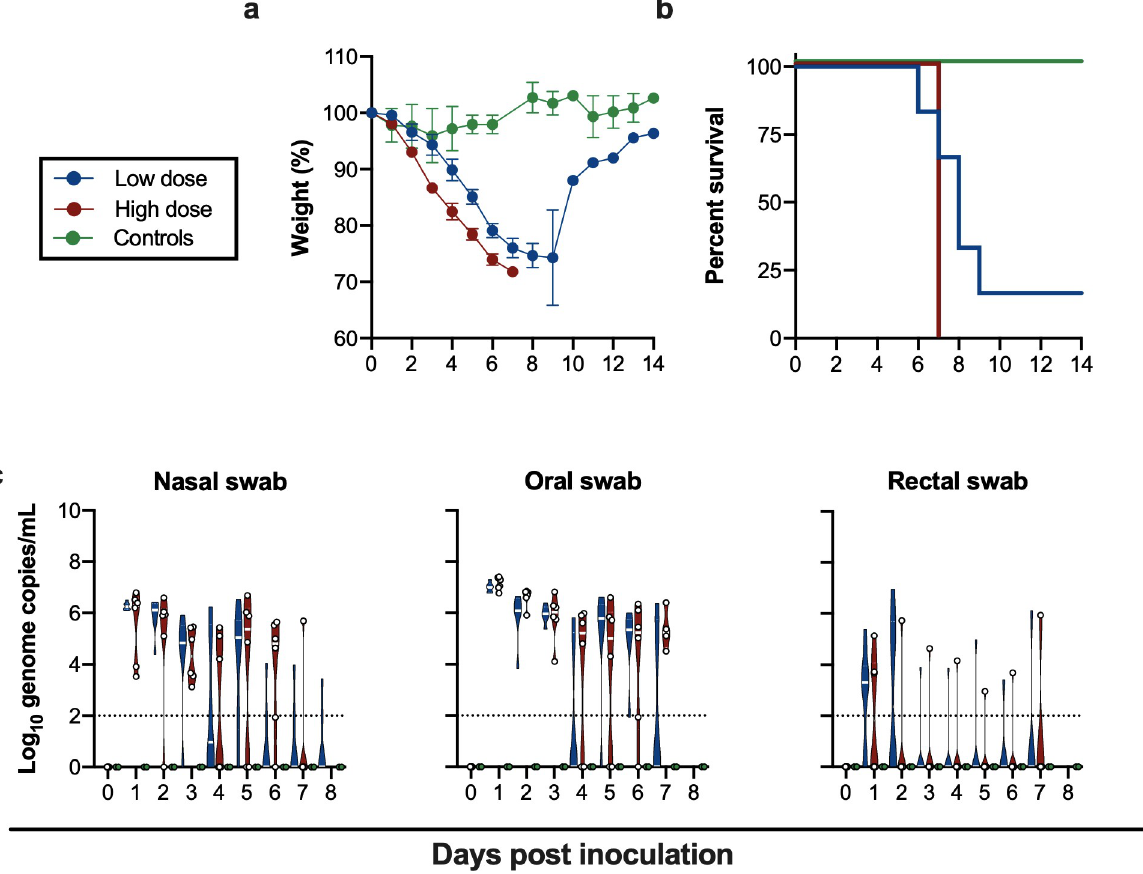
Fig 1. Inoculation of K18-hACE2 mice results in lethal infection and virus shedding. . a . Relative weight loss in mice after SARS-CoV-2 inoculation. The lines represent mean ± SEM. Wilcoxon matched-pairs rank test was conducted to compare weight differences between groups. b . Survival curves of mice inoculated with 10 4 or 10 5 TCID 50 SARS-CoV-2 , or 10 5 γ -irradiated SARS-CoV-2. c . Violin plot of viral load in nasal, oropharyngeal and rectal swabs with median as centre. Blue: 10 4 TCID 50 (low dose animals, n = 6); red: 10 5 TCID 50 (high dose animals, n = 6); green: 10 5 TCID 50 γ -irradiated (control animals, n = 2); dotted line = limit of detection.